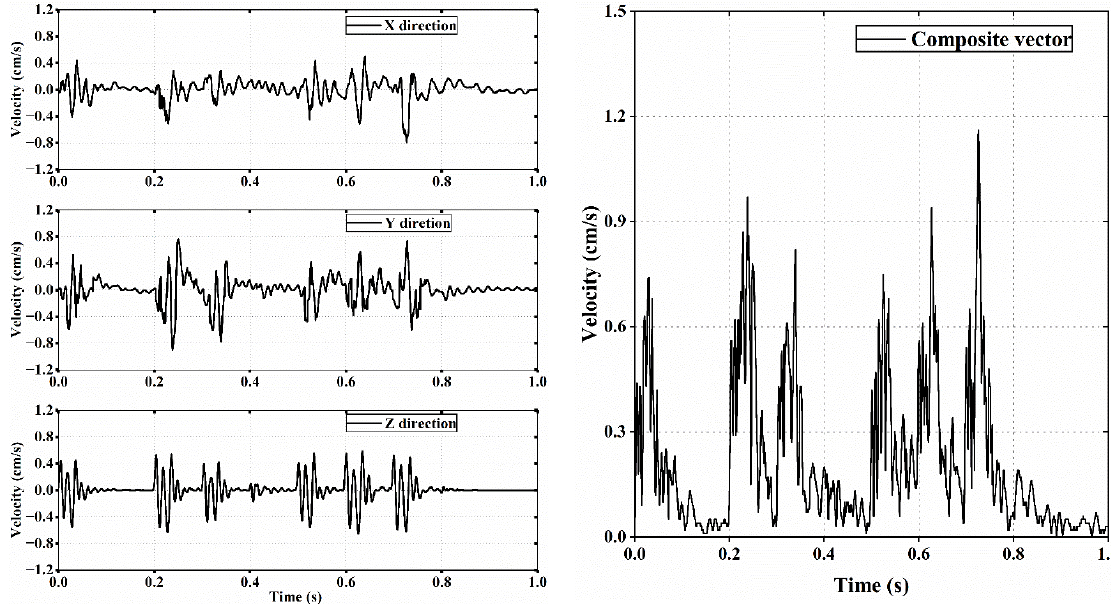
Figure 5. Vibration velocity curve in each direction at ground-soil-monitoring point T5. Table 2. Data monitored from the pipeline vibration levels survey.